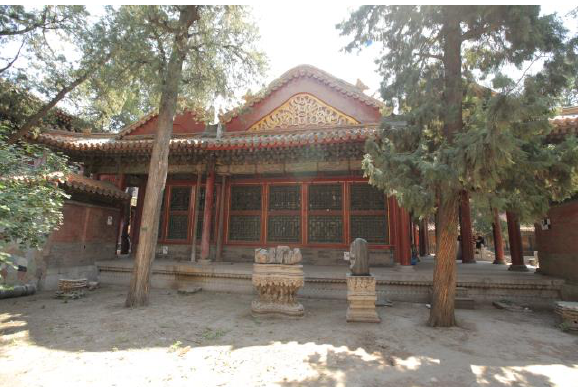
Figure 10. Main Hall of Jingfu Palace, Forbidden City (the Place Museum), Beijing